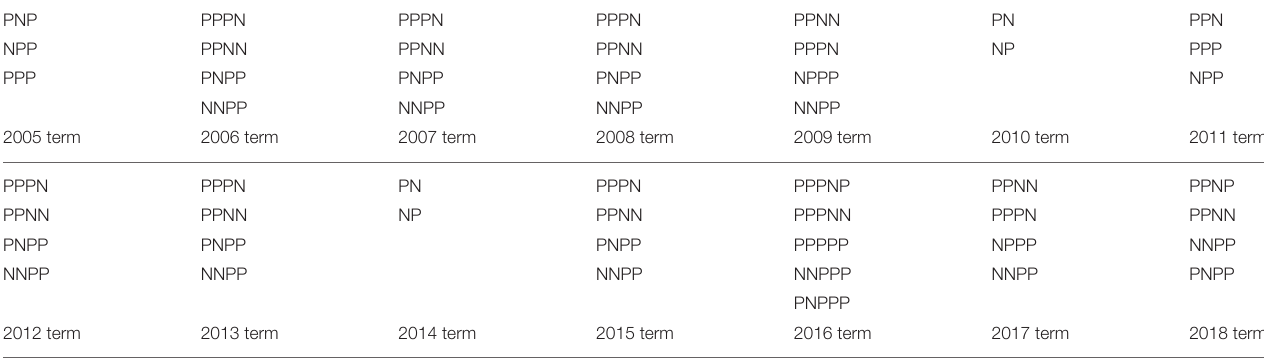
TABLE 1 | The blockmodel structures for delineating the fundamental structure of the Roberts